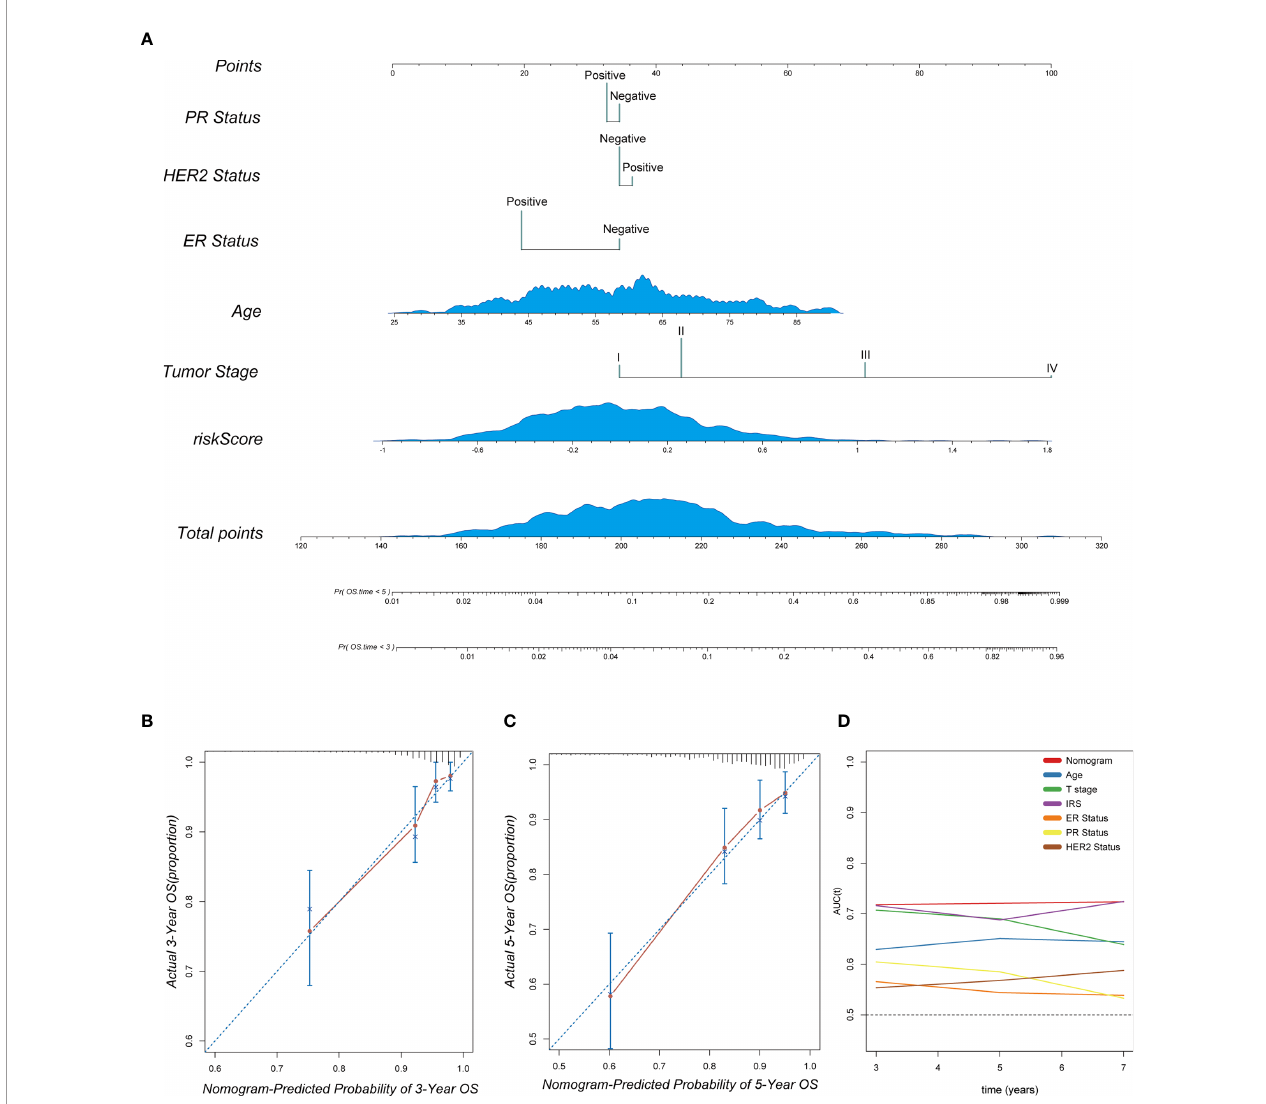
FIGURE 10 | The combination of the IRS signature and clinicopathological features improves survival prediction. (A) A nomogram was constructed to predict 3- and 5-year OS in individual breast cancer patients. (B, C) Calibration analysis indicated a high accuracy of 3- and 5-year survival prediction. (D) tROC analysis demonstrated that the nomogram was the most stable and powerful predictor for OS among all the clinical